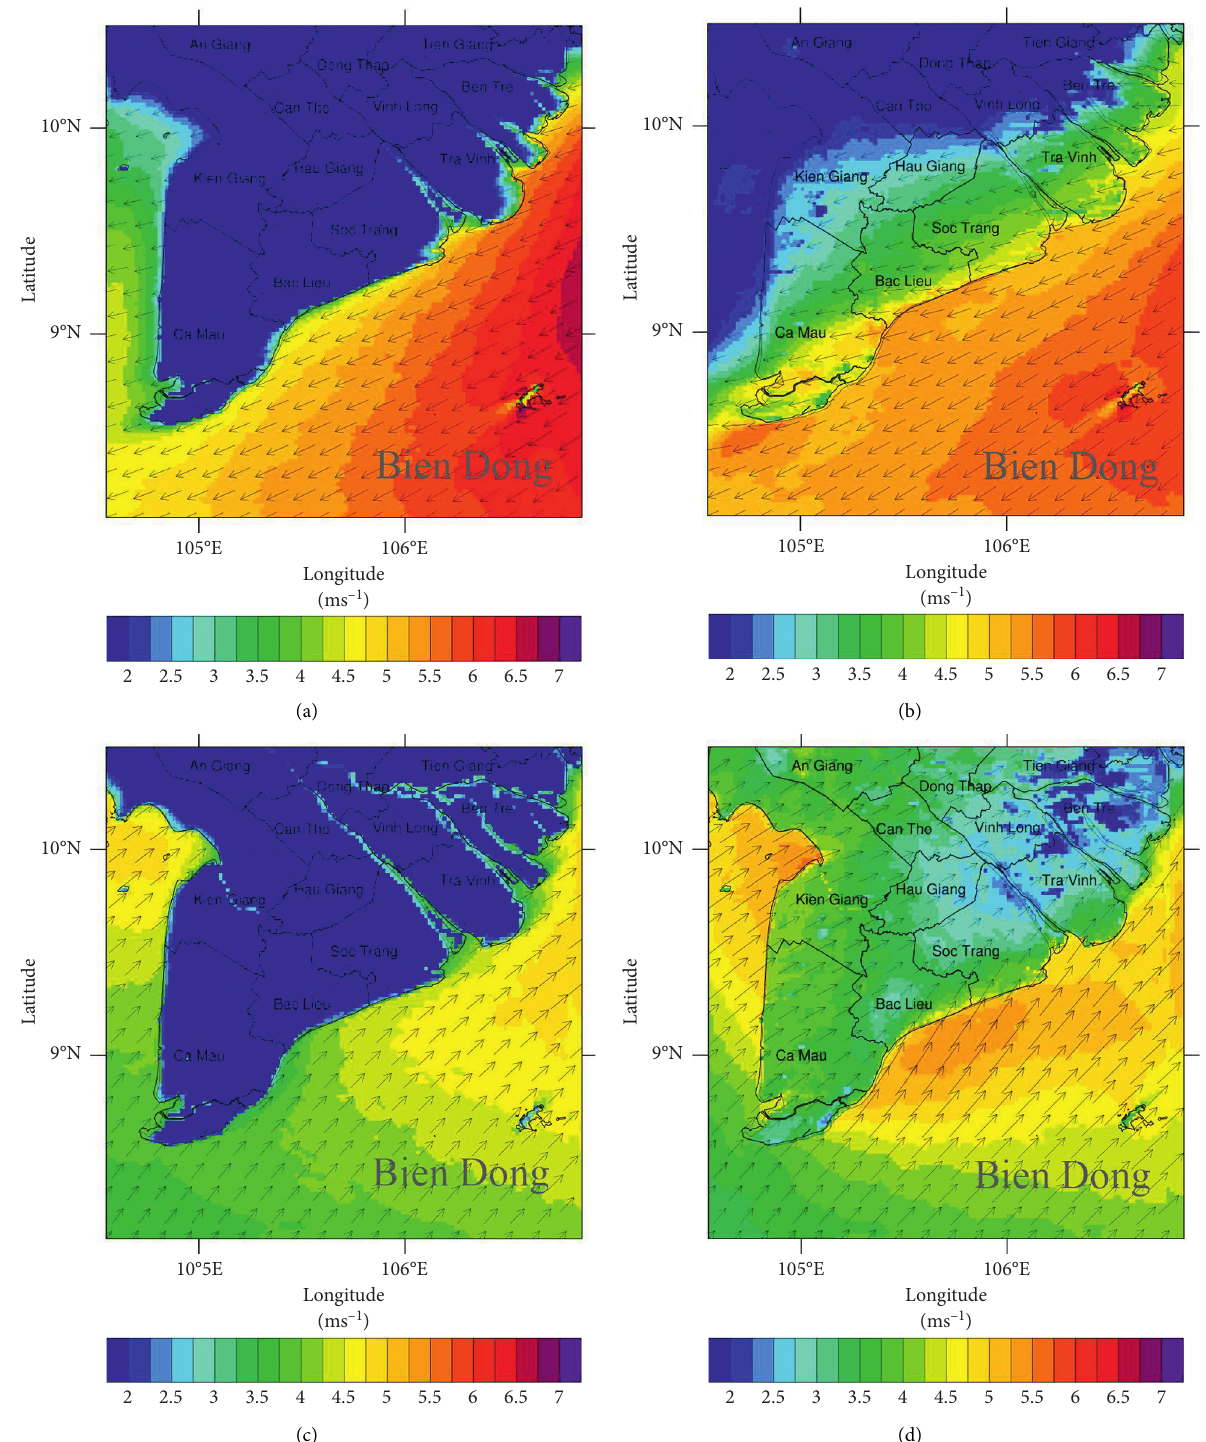
Figure 10: Annual mean of wind speed (m s − 1 ) and wind vector (vector) at 20 m level in Southern Vietnam region for winter (DJF) at (a) 05 LT and (b) 14LT and summer (JJA) at (c) 05LT and (d)